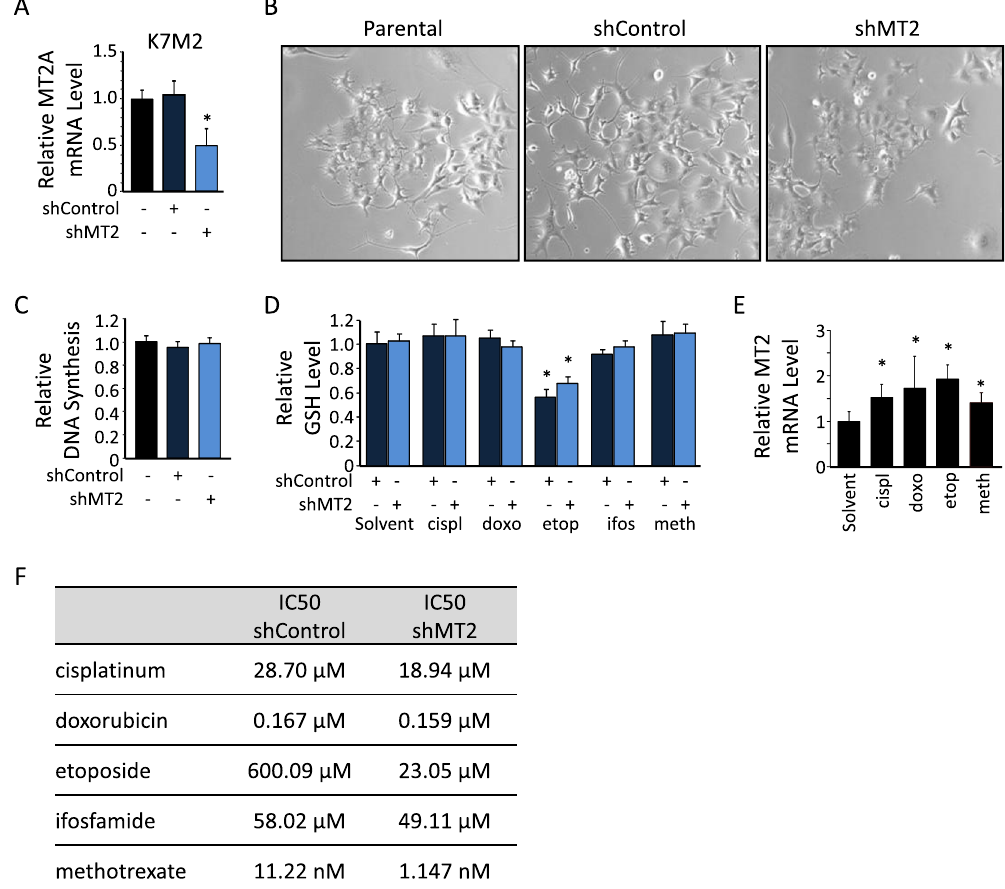
Figure 3. Characterization of MT2-silenced murine cell line. ( A ) Expression levels of MT2 in parental and stably modified K7M2 cells, as assessed by RT-qPCR. GAPDH was used as internal reference gene. The relative mRNA level was calculated using the 2 −ΔΔ CT method and expressed as mean ± standard deviation (n = 3). An asterisk ( * ) indicates a statistically significant difference vs . shControl group ( p < 0.05). ( B ) Representative images of parental, and shControl- or shMT2-modified K7M2 cells (200X magnification). ( C ) Relative DNA synthesis, as assessed by a BrdU incorporation colorimetric assay. Results are expressed as fold change value normalized to parental cells (mean ± standard deviation; n = 8). ( D ) Relative glutathione (GSH) level in shControl- or shMT2-modified K7M2 cells incubated in the presence of the indicated drugs, as assessed by a colorimetric assay. Results are expressed as fold change value normalized to untreated cells (mean ± standard deviation; n = 4). ( E ) Expression level of MT2 in parental K7M2 cells incubated for 24 h in the presence of the indicated drugs, as assessed by RT-qPCR. An asterisk ( * ) indicates a statistically significant difference vs . solvent ( p < 0.05). ( F ) Half maximal inhibitory concentrations (IC50) for chemotherapy. Cell viability was assessed in murine K7M2 cell line incubated for 24 hrs in the presence of increasing doses of each indicated